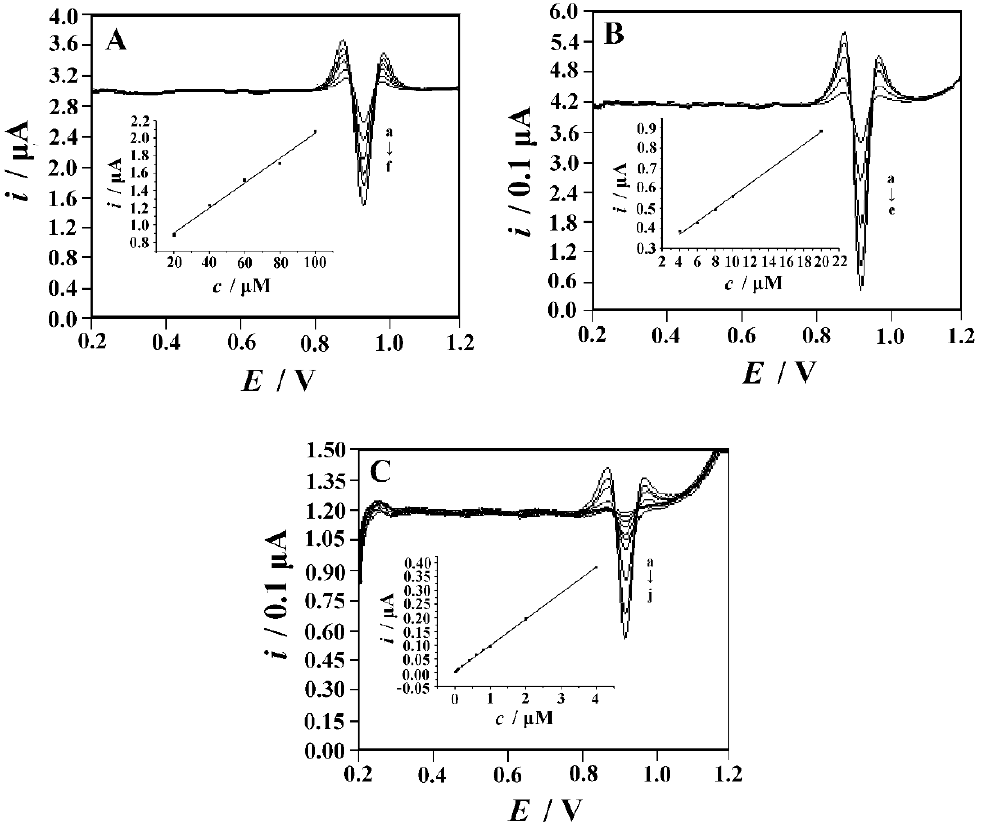
Figure 9. The second-order derivative linear scan voltammograms obtained at MIP/ABPE in a 0.1 M phosphate buffer (pH 7.0) and different concentrations of Trp: ( A ) from a to f : 10, 20, 40, 60, 80, 100 μ M; ( B ) from a to e: 1.0, 2.0, 4.0, 6.0, 8.0 μ M; ( C ) from a to j: 0.01, 0.02, 0.04, 0.06, 0.08, 0.1, 0.2, 0.4, 0.6, 0.8 μ M, The inset of ( A ), ( B ), ( C ) shows the calibration curves of Trp in the range of 20–100 μ M, 4–20 μ M and 0.01–4 μ M, respectively. Accumulation potential: − 0.1 V, accumulation time: 180 s, scan rate: 0.1 V s − 1 .